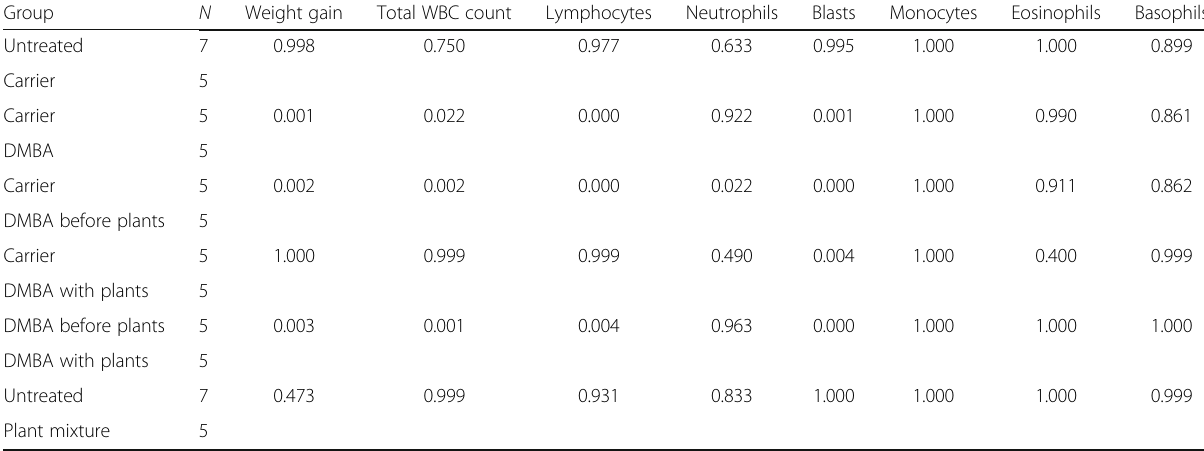
Table 1 Significance level for the comparison of weight gain, total WBC count, and the percentage of lymphocytes, neutrophils, blasts, monocytes, eosinophils, and basophils between the different rat groups (untreated, carrier, DMBA, DMBA before plants, DMBA with plants, and plant mixture) by descriptive one-way ANOVA and Tukey ’ s HSD analysis Group N Weight gain Total WBC count Lymphocytes Neutrophils Blasts Monocytes Eosinophils Basophils Untreated 7 0.998